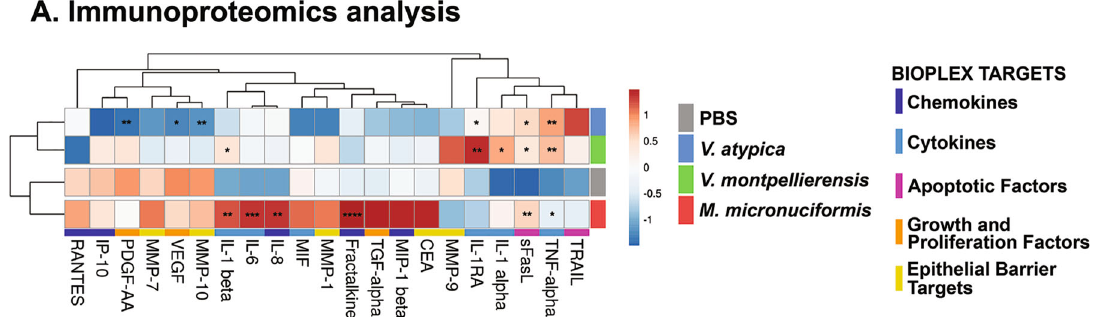
Fig. 2 M. micronuciformis infections induced greater secretion of pro-in fl ammatory cytokines and chemokines, but V. atypica infections signi fi cantly decreased the culture concentration of some barrier targets. A Hierarchical clustering analysis (HCA) of immunoproteomics data from human 3-D cervical epithelial cells infected with V. atypica, V. montpellierensis, or M. micronuciformis under anaerobic conditions for 24 h. Statistical signi fi cance was determined using one-way ANOVA with Dunnett ’ s adjustment for multiple comparisons relative to PBS; * P < 0.05, ** P < 0.01, *** P < 0.001, **** P < 0.0001. Color labels for each bacterial infection are observed to the right of the HCA and are as follows: PBS (gray), V. atypica (blue), V. montpellierensis (green), and M. micronuciformis (red). Protein targets (bottom of HCA) were color-coded in order to visualize clustering patterns of the protein targets: apoptotic factors (pink), epithelial barrier targets (yellow), growth and proliferation factors (orange), chemokines (dark blue), and cytokine (light blue). Individual concentrations can be visualized on graphs in the supplementary information (Supplementary Figs. 2 –